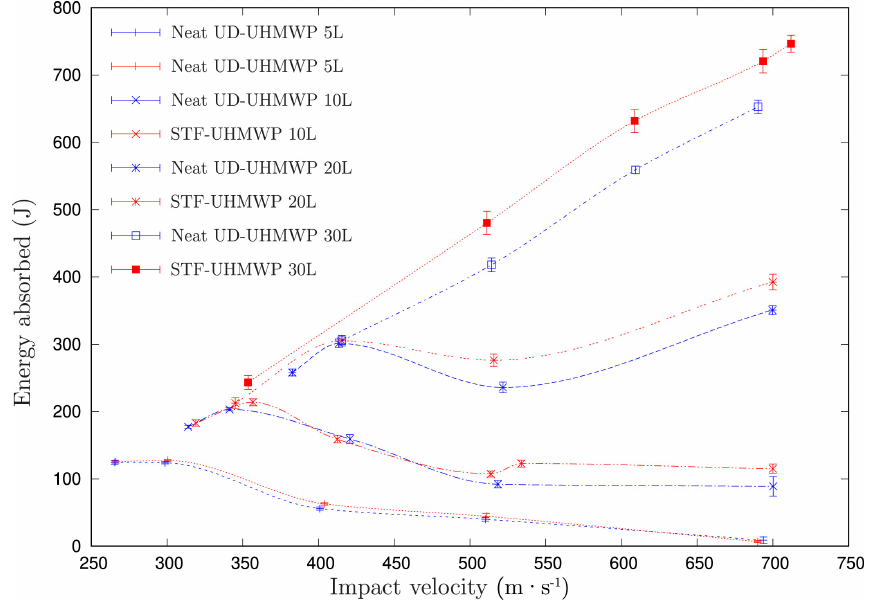
Figure 8. Variation of energy absorbed with the impact velocity of completely penetrated neat and STF-impregnated panels of different layers. Reprinted with permission from Ref. [81]. Copyright 2022,